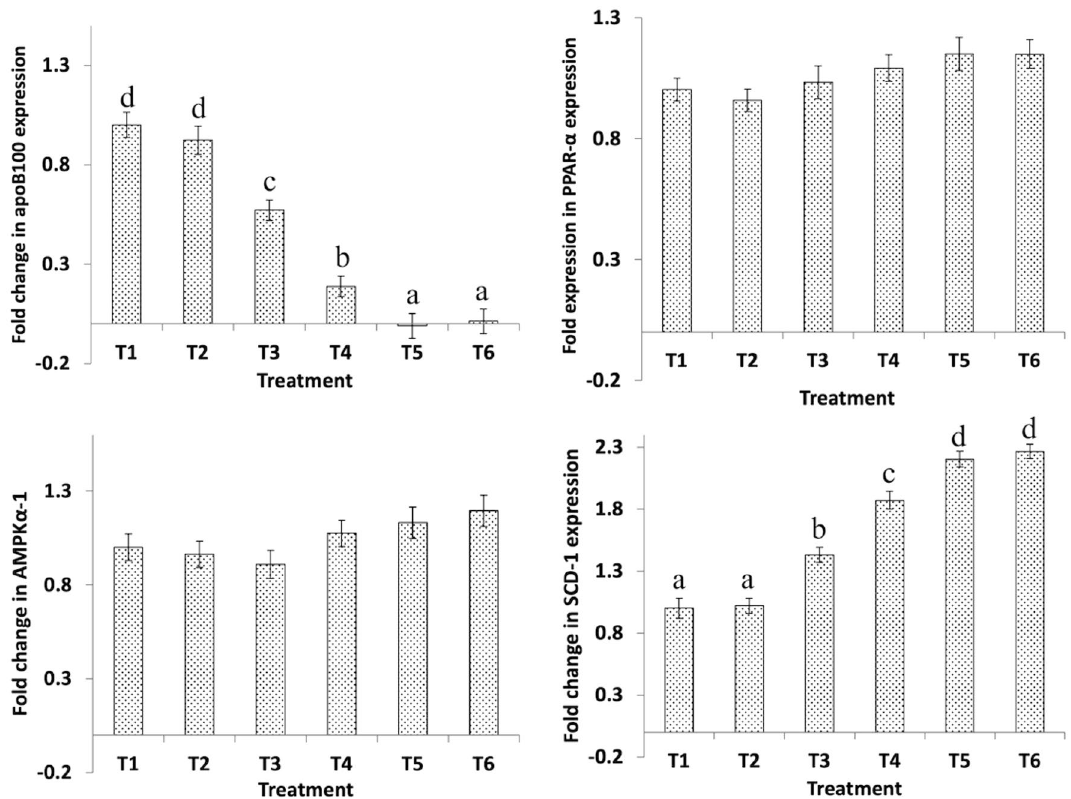
Figure 4. Effect of dietary B. Bifidum (BFD) and mannan-oligosaccharides (MOS) on hepatic apoB100, PPAR-α, AMPKα-1, and SCD-1 gene expression in 42 days old broiler chicken. T 1 (no BFD/MOS/BMD), T 2 (20 mg BMD/kg diet), T 3 (0.1% MOS + 10 6 cfu BFD/g feed), T 4 (0.1% MOS + 10 7 cfu BFD/g feed), T 5 (0.2% MOS + 10 6 cfu BFD/g feed), T 6 (0.2% MOS + 10 7 cfu BFD/g feed). Results are presented as means ± SEM with six birds per treatment. Means values with different superscripts letters differ significantly (P <